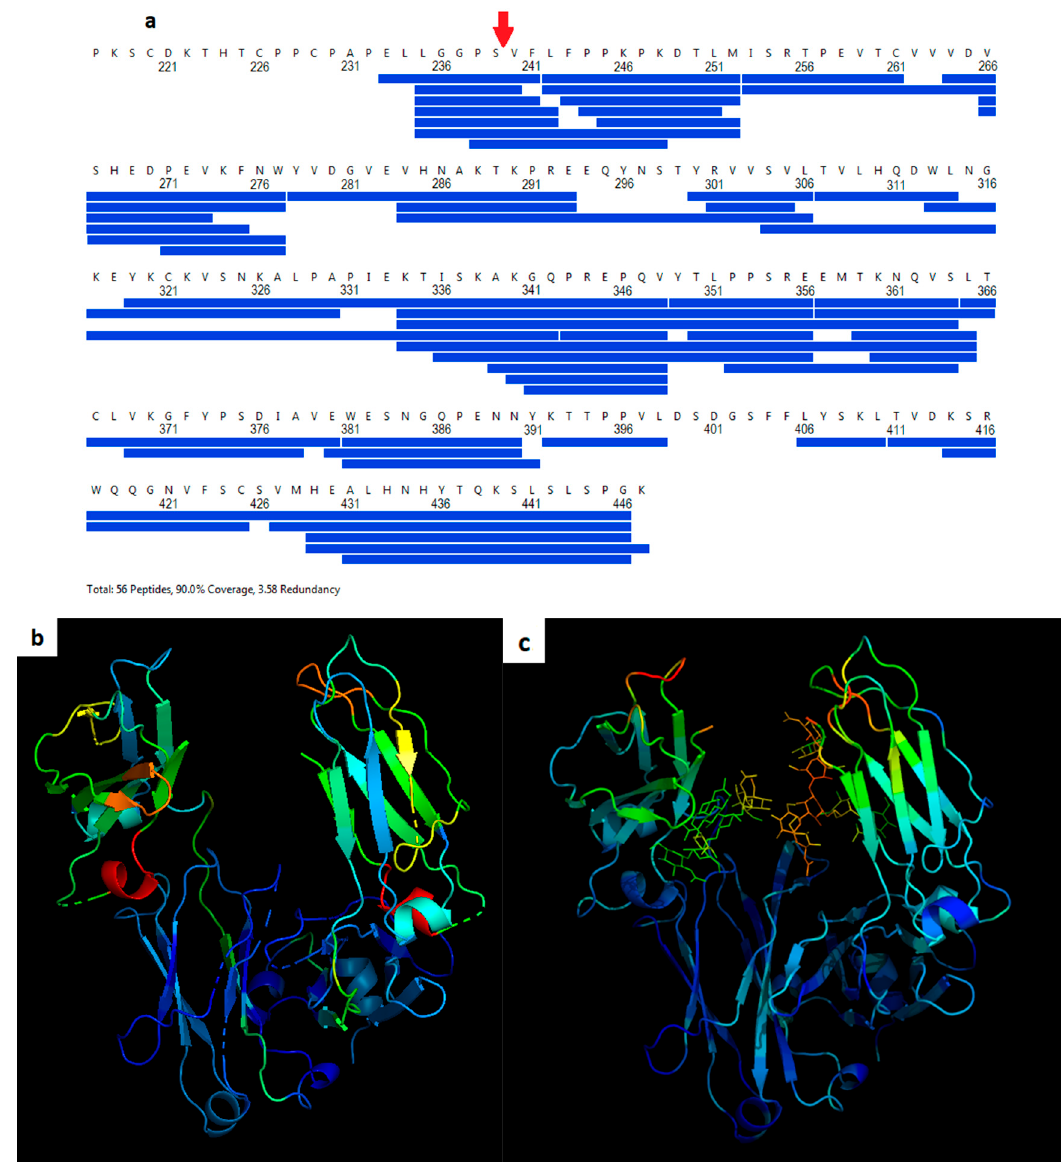
Figure 2. Dynamics of Fc-C239i. ( a ) Coverage map for hydrogen-deuterium exchange. The insertion site after Ser 239 is indicated with a red arrow. ( b ) Heat map based on hydrogen-deuterium exchange (HDX) mass spectrometry. Colors show the range of measured mobility increases, using a spectrum from blue for the lowest values to red for the highest. Observed percent changes in HDX range from − 2% to + 19% (see Figure S2). Warmer colors represent regions of higher di ff erential exchange (mutant minus wild-type HDX measurements of the peptide fragments provided full coverage of the backbone sequence with the exception of residues 253, 278, 392, and 399–406 (shown with dashes)). ( c ) Heat map based on crystallographic thermal displacement values (B-factors). Warmer colors show areas where the insertion increases B values relative to wild-type. The crystallographic data also include the glycans.